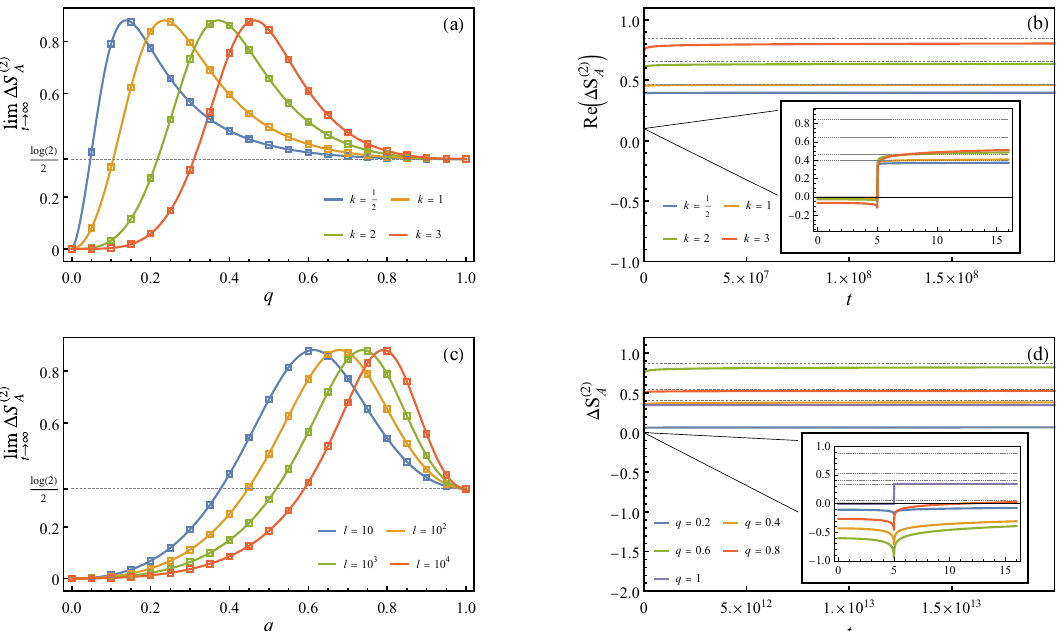
Figure 5. (a) and (c): the late time limits of ∆ S (2) with respect to the mixing factor q in σ + I - A excitation. The regulator is chosen to be (cid:15) = 10 − 5 ; (b): the full-time evolution of Re [∆ S (2) ] in A σ + I -excitation. Parameters are selected as q = 0 . 5 , x = ˜ x = − 5 , (cid:15) = 10 − 5 . The dashed lines are the theoretical limits derived from eq. (3.49) for the corresponding parameters; (d): the full-time evolution of ∆ S (2) in σ + I -excitation. Parameters are selected as x = − ˜ x = ± 5 , (cid:15) = 10 − 5 . The A dashed lines are the theoretical limits derived from eq. (3.49) for the corresponding